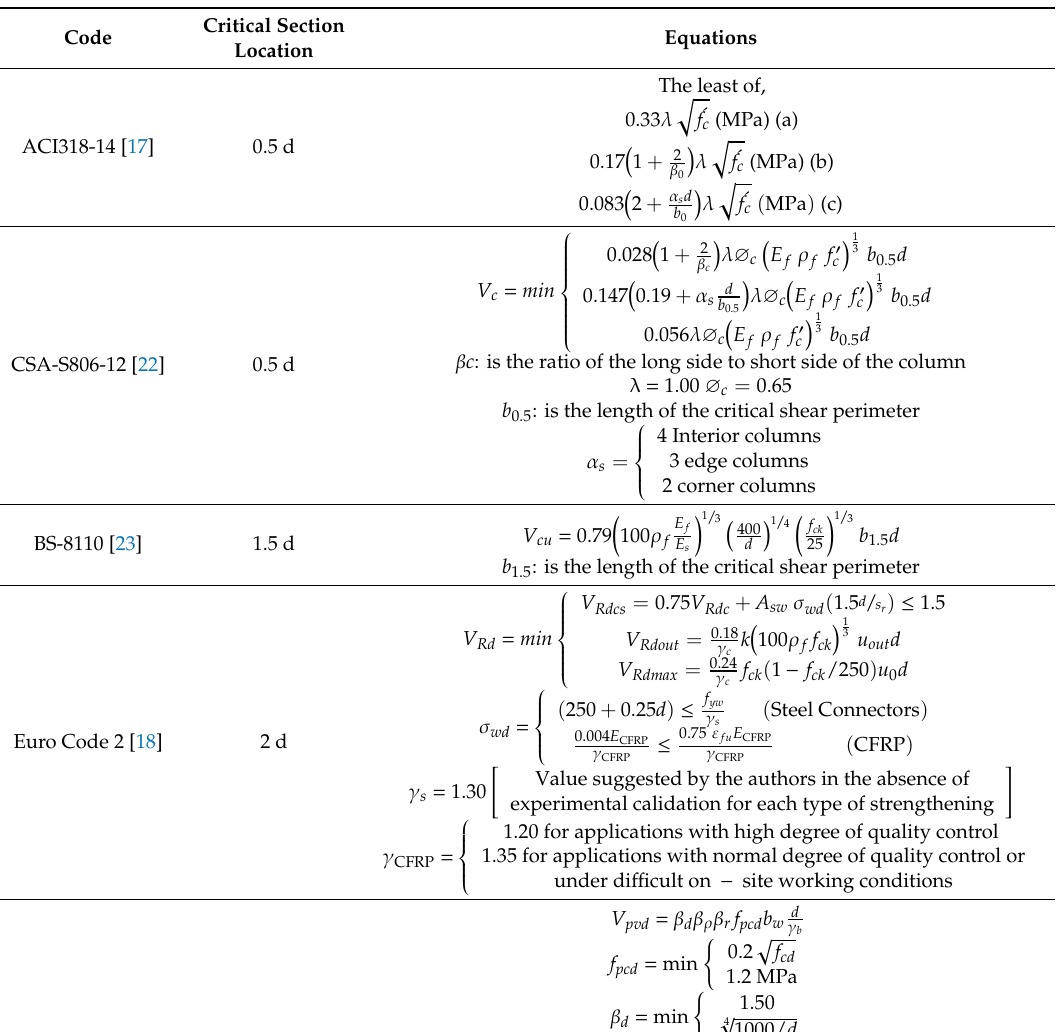
Table 2. International code equations for design punching